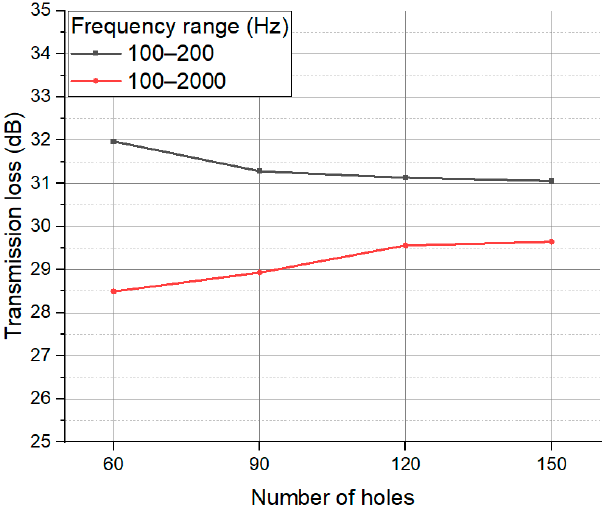
Figure 29. Average transmission loss according to the variation of the number of holes in the outer resonate type.